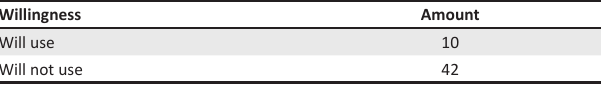
TABLE 2b: Willingness of Lecturers who Learned NC before English to Teach Using NC.